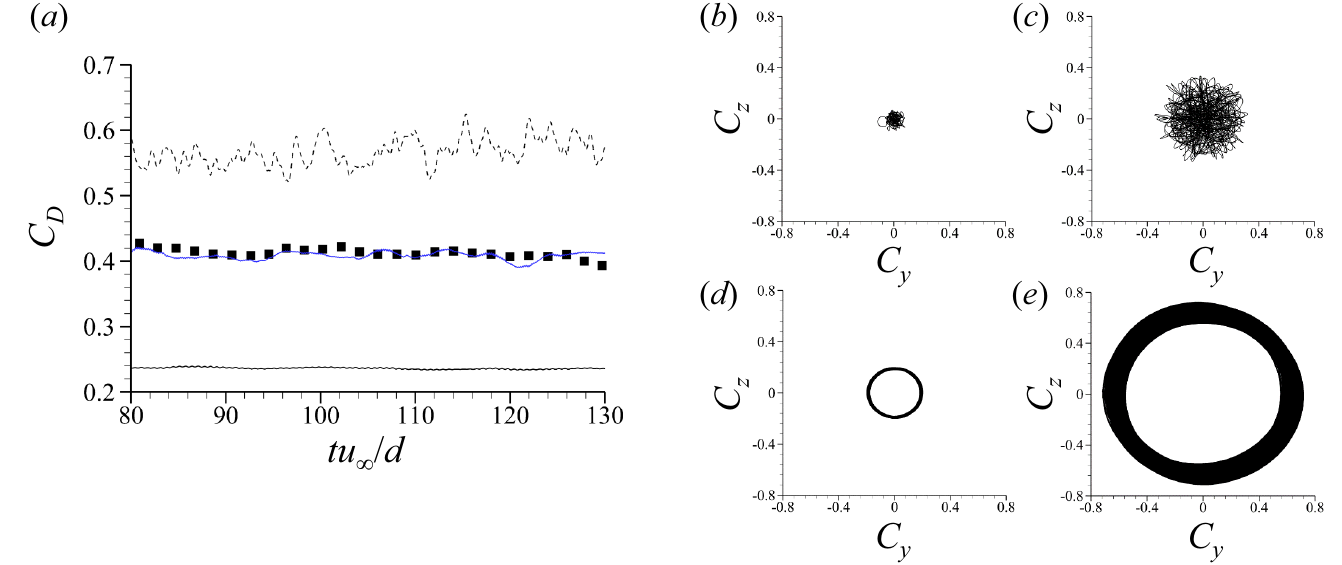
Figure 6. Time traces of force coefficients for various forcing frequencies: ( a ) C D versus the time; ( b ) C y – C z for the uncontrolled flow; ( c ) C y – C z for f ∗ = 0.25; ( d ) C y – C z for f ∗ = 1.5; ( e ) C y – C z for f ∗ = 5.0. For ( a ), (cid:4) , without control; – – – (black), f ∗ = 0.25; —— (black), f ∗ = 1.5; —— (blue), f ∗ =